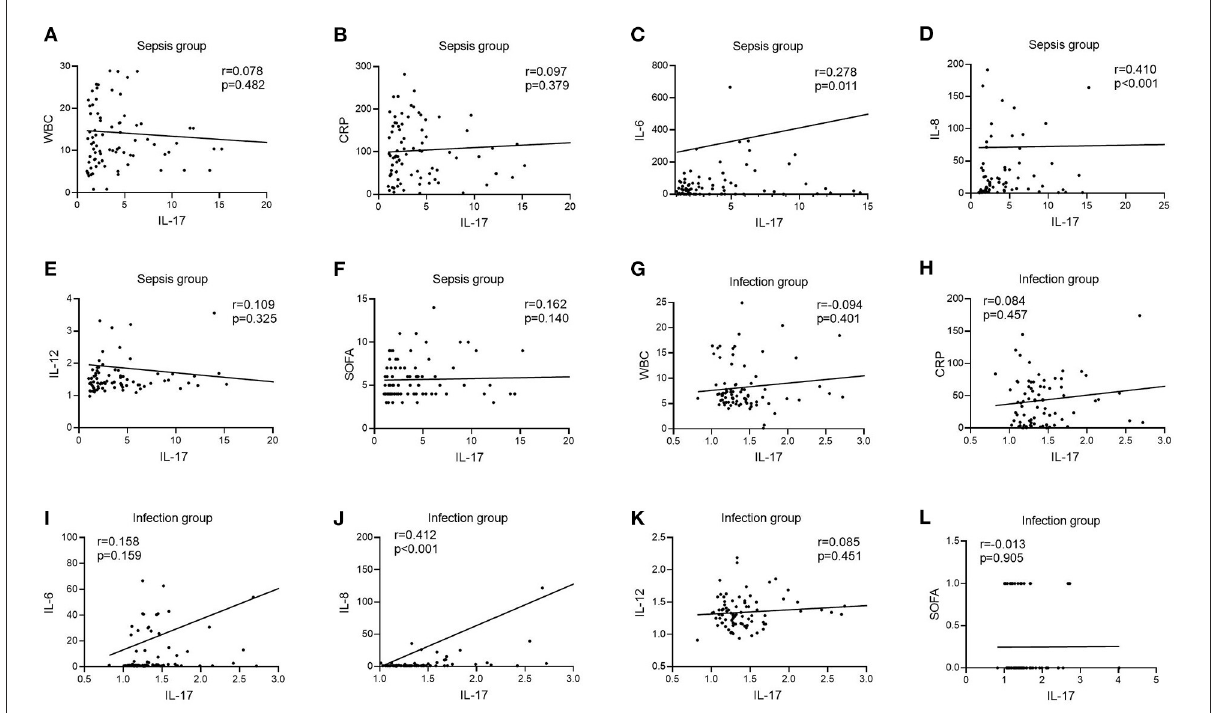
FIGURE4 Correlation of IL-12 with WBC, CRP, IL-6, IL-8, IL-12, and SOFA scores in patients in the infection and sepsis groups. (A) Correlation of IL-12 with WBC in patients in the sepsis groups; (B) Correlation of IL-12 with CRP in patients in the sepsis groups; (C) Correlation of IL-12 with IL-6 in patients in the sepsis groups; (D) Correlation of IL-12 with IL-8 in patients in the sepsis groups; (E) Correlation of IL-12 with IL-12 in patients in the sepsis groups; (F) Correlation of IL-12 with SOFA scores in patients in the sepsis groups; (G) Correlation of IL-12 with WBC in patients in the infection groups; (H) Correlation of IL-12 with CRP in patients in the infection groups; (I) Correlation of IL-12 with IL-6 in patients in the infection groups; (J) Correlation of IL-12 with IL-8 in patients in the infection groups; (K) Correlation of IL-12 with IL-12 in patients in the infection groups; (L) Correlation of IL-12 with SOFA scores in patients in the infection